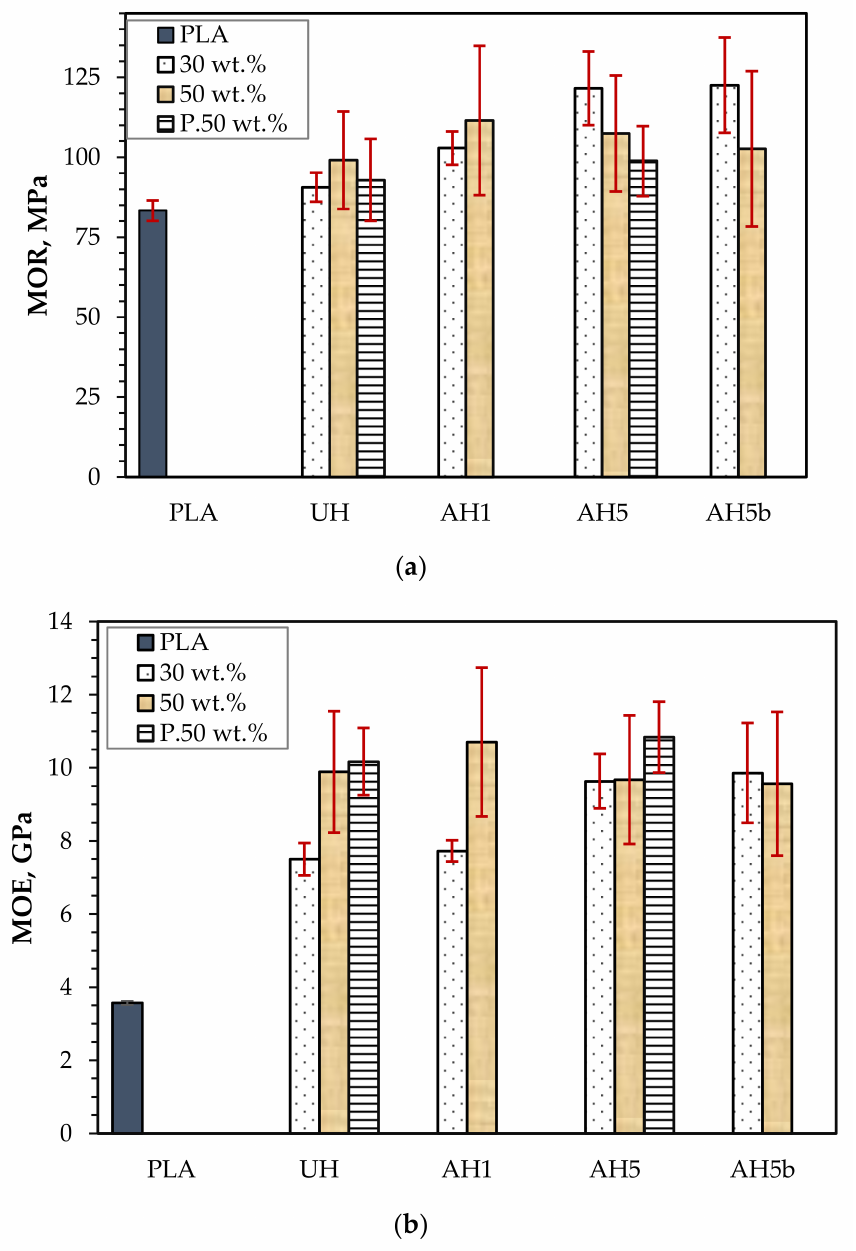
Figure 9. ( a ) MOR and ( b ) MOE of neat PLA and 30 and 50 wt.% untreated hemp fiber reinforced composites (UH) and composites of alkali-treated hemp fibers (AH1, AH5 and